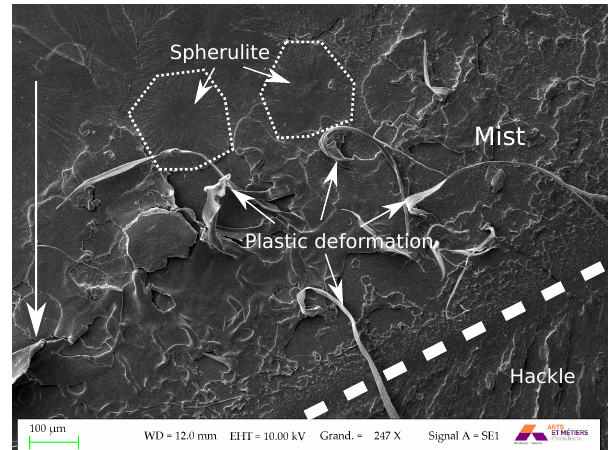
Figure 5. Observation by electron microscopy of the mist zone of the fracture surface of sample B4. Several zones can be identified (from top to bottom): the smooth zone with the appearance of spherulites (end of the zone of conical marks) - the mist zone with plastic deformation of the resin - a stop mark of the macro-crack in dotted line - the hackle zone. The long arrow on the left indicates the direction of